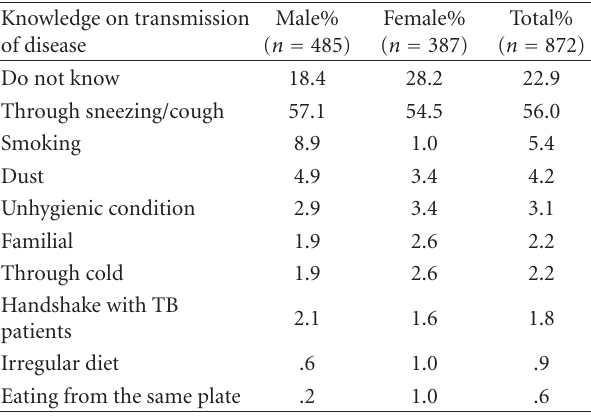
Table 4: knowledge on ways of transmission of disease (TB).